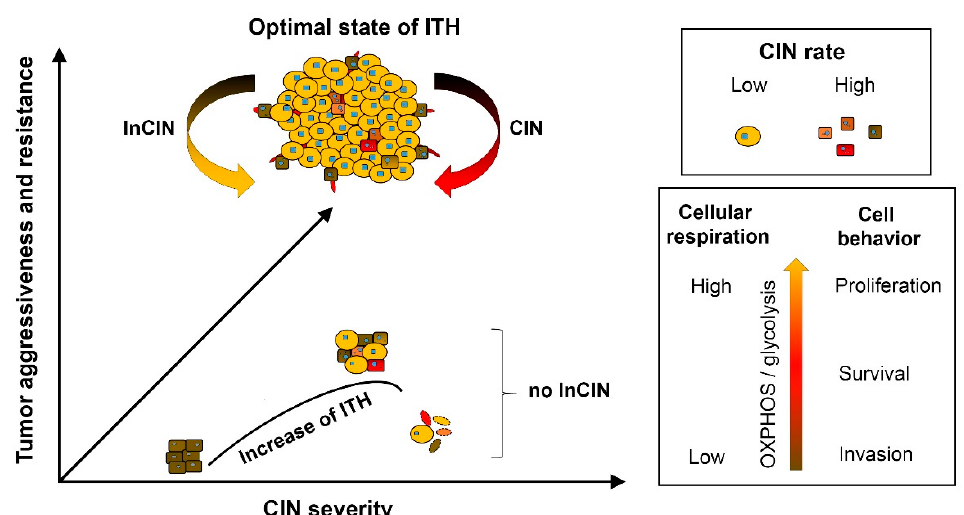
Figure 2. The cancer evolutionary tactic of controlling and optimizing the state of ITH. In the late steps of cancer evolution, neo-transformed cells become different functional components of a tumor, which defines intra-tumoral heterogeneity (ITH). The common metabolic feature of different tumor subpopulations is using glycolysis on top of oxidative phosphorylation (OXPHOS). The common genomic feature of tumor cells is aneuploidy. Tumor ecology streamlines tumor subpopulations to the essential ones, leading to optimal state of ITH. This leads to aggressive behavior of tumor and resistance to adverse microenvironmental factors. CIN speeds up cancer evolution by increasing ITH, while inhibition of CIN (InCIN) maintains the optimal state of ITH.